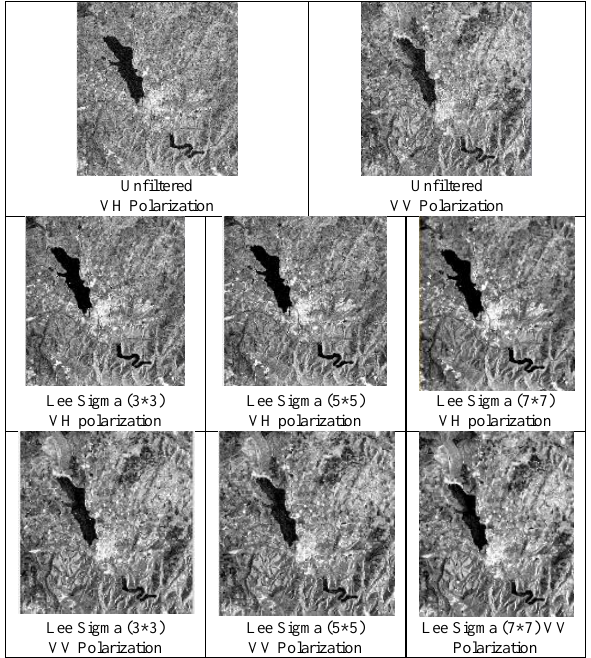
Figure 4. Unfiltered VV and VH polarized images and application results of different filter sizes (a part of May 5 th , 2018 Sentinel-1